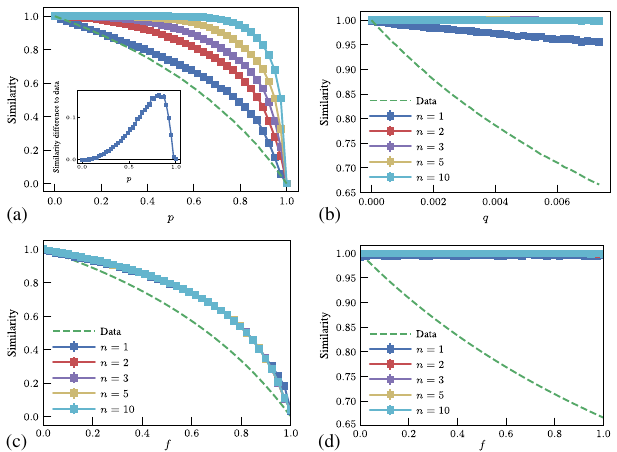
FIG. 7. (a) Edge denoising reconstruction performance for the openflights data, as a function of the missing edge probability p , for various n , and q ¼ 0 . The dashed curve shows the corre- sponding value obtained directly with the measured data with n ¼ 1 , and the inset shows the difference between the curve for n ¼ 1 and the dashed curve. (b) The same as (a) but for nonedge denoising, with p ¼ 0 . The values of q are chosen to yield the same number of affected nonedges as edges in (a). (c) Edge completion reconstruction performance as a function of the fraction f of unobserved edges. The dashed line shows the value of similarity obtained by considering the unobserved edges as nonedges. (d) The same as (c) but for nonedge completion, as a function of the fraction f of unobserved nonedges. The dashed line shows the value of similarity obtained by considering the unobserved nonedges as